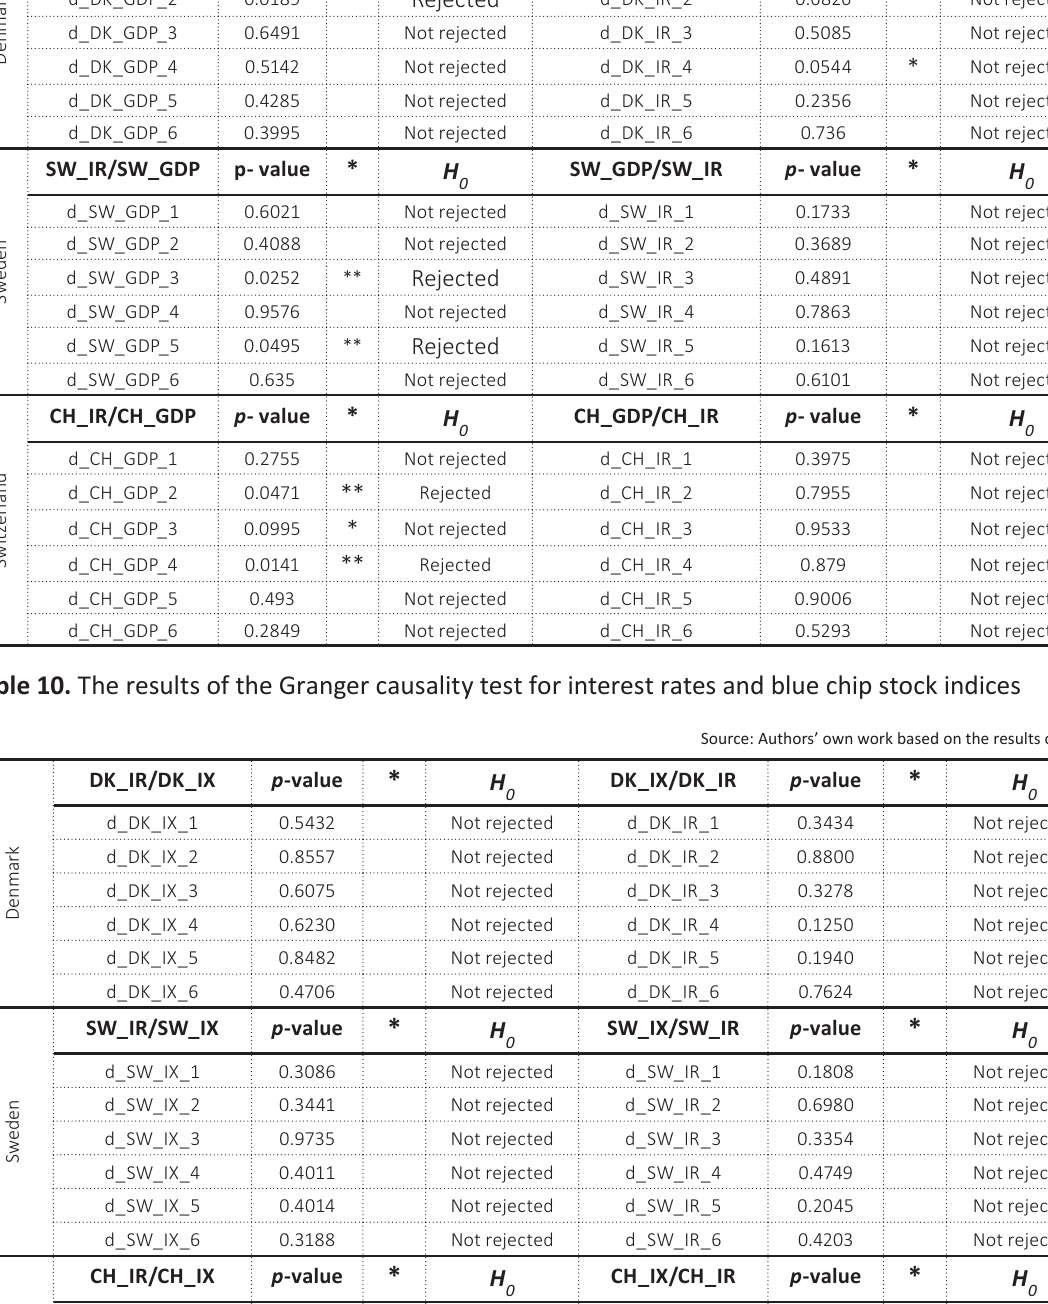
Table 9. The results of the Granger causality test for interest rates and GDP